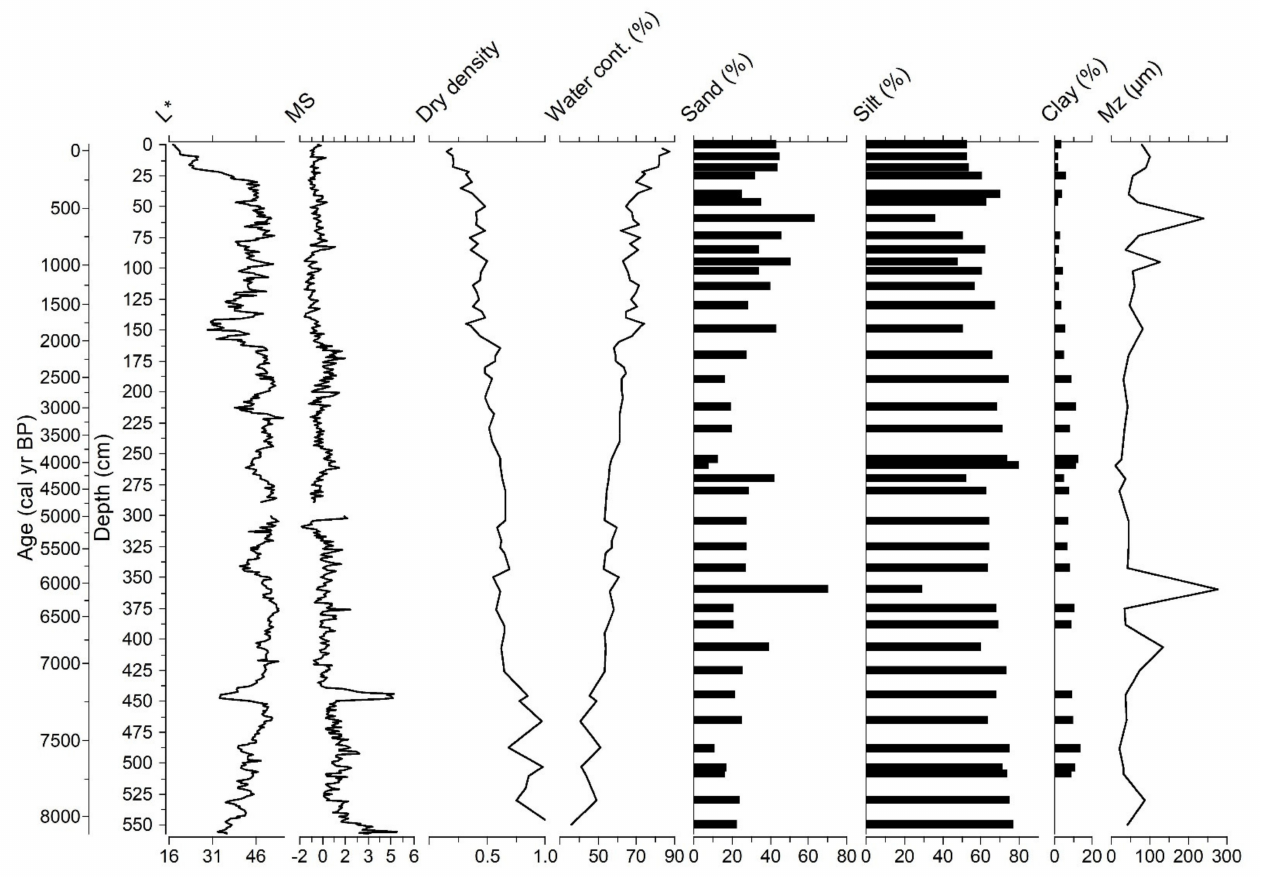
Figure 6. Color brightness (L*), magnetic susceptibility (MS; 10 − 5 SI), dry density (g/cm 3 ), water content, and grain-size down-core variation in the sediment core VB-2 from Lake Velo